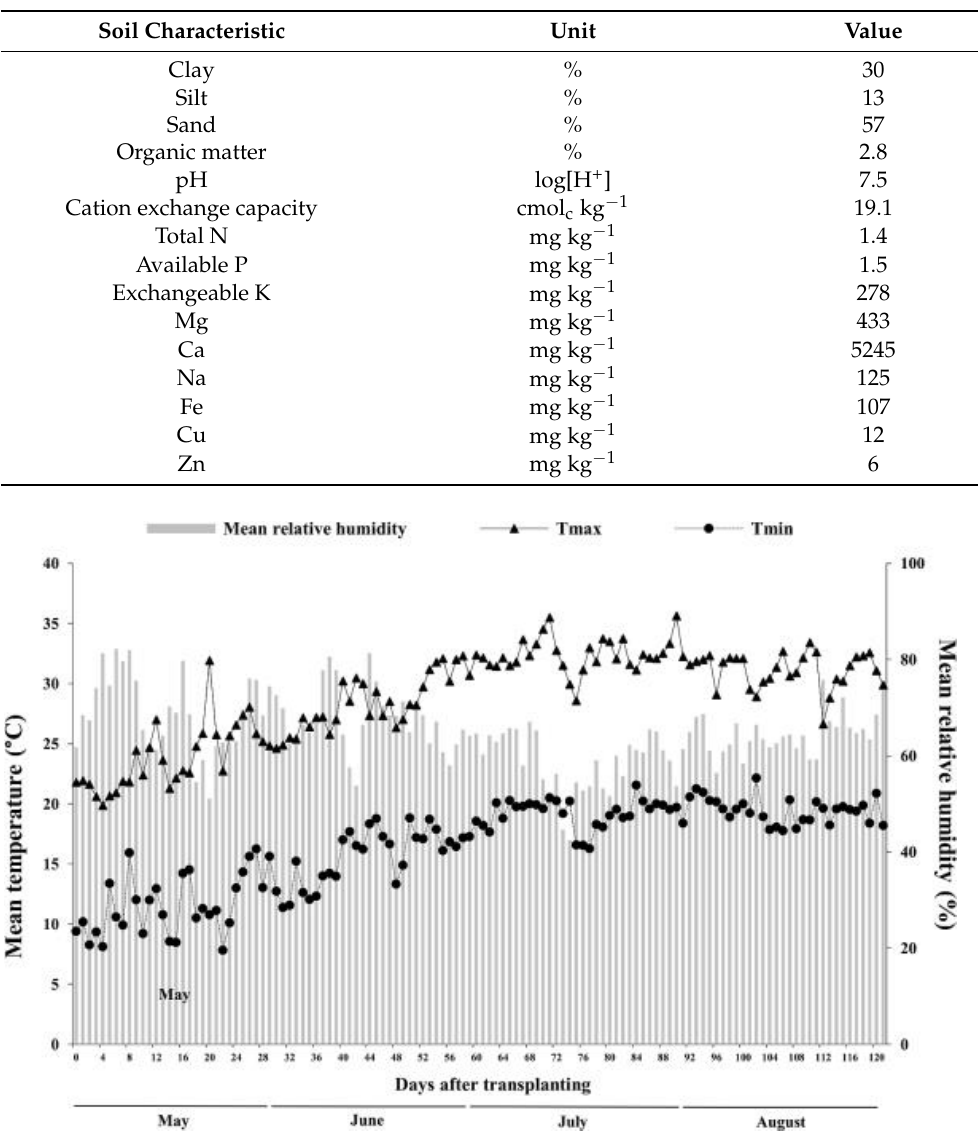
Figure 1. Meteorological conditions recorded during the